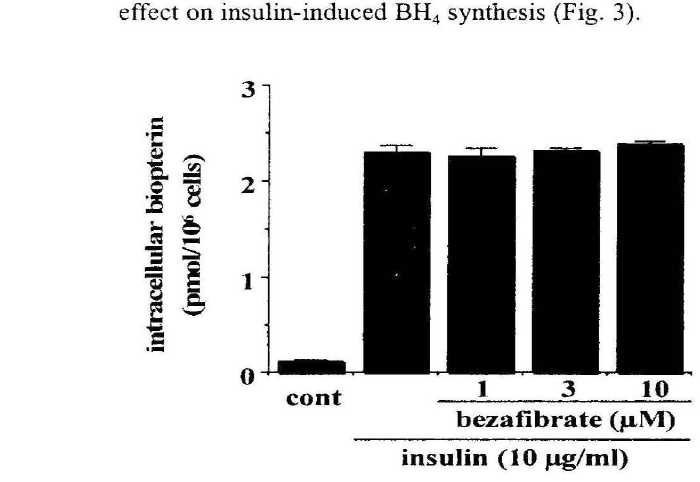
Figure 3. Effect of bezafibrate on insulin-induced increase in BH4 content in endothelial cells. Cells were incubated with insulin (10 )lg/ml) in the presence or ° ahsence of bezafibrate (1-1 I-lM) for 24 h. Typical data from 3 experiments are shown as mean - S.E.M. of quadruplicate